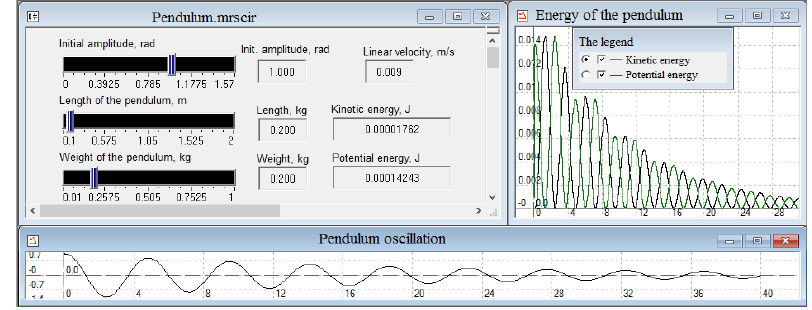
Fig. 6. Visual layer of the Physical Pendulum TIM Students can vary output parameters of the model and observe changes in the oscillation amplitude of the pendulum, its velocity, kinetic and potential energy. Depending on the competencies desired as the outcome of the course, complexity of the task can be